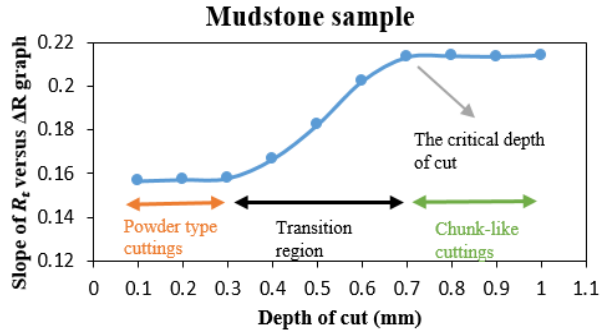
Figure 29. The slope of 𝑅 𝑡 versus ∆𝑅 variation at different DOCs for the mudstone sample.